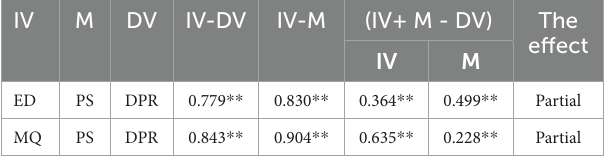
TABLE 10 Analysis of the mediating effect of patient satisfaction.